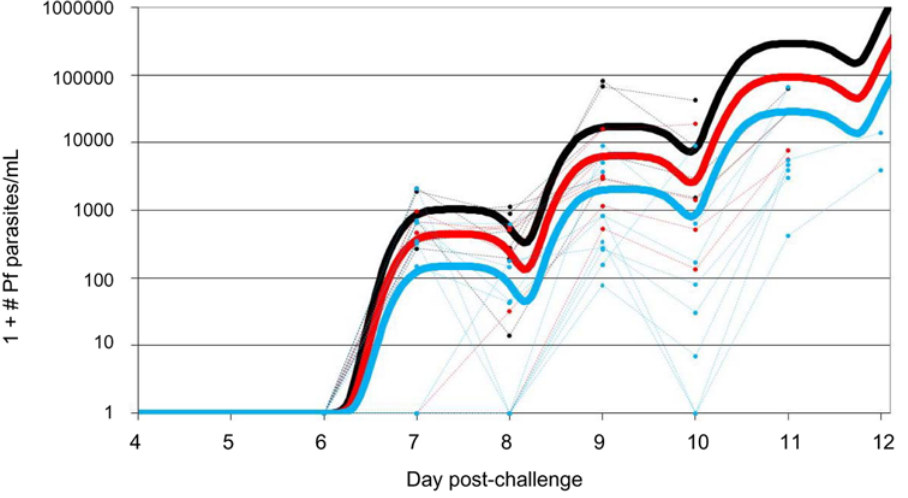
Figure 6. In-vivo growth of blood stage parasites after P.falciparum challenge. Observed parasite densities of individuals (dots) and predicted kinetics (as a group, thick continuous line) in the three immunization groups experimentally infected with Plasmodium falciparum (3D7). Dots represent observed number of parasites per milliliter of blood based on qPCR results. Individuals in the same group are represented in the same color (Infectivity Controls: black (n=6), Full dose AMA-1/ASO1B: red (n=6), Full dose AMA-1/ASO2A: blue (n=10)). All data points represent pretreatment parasitemias.